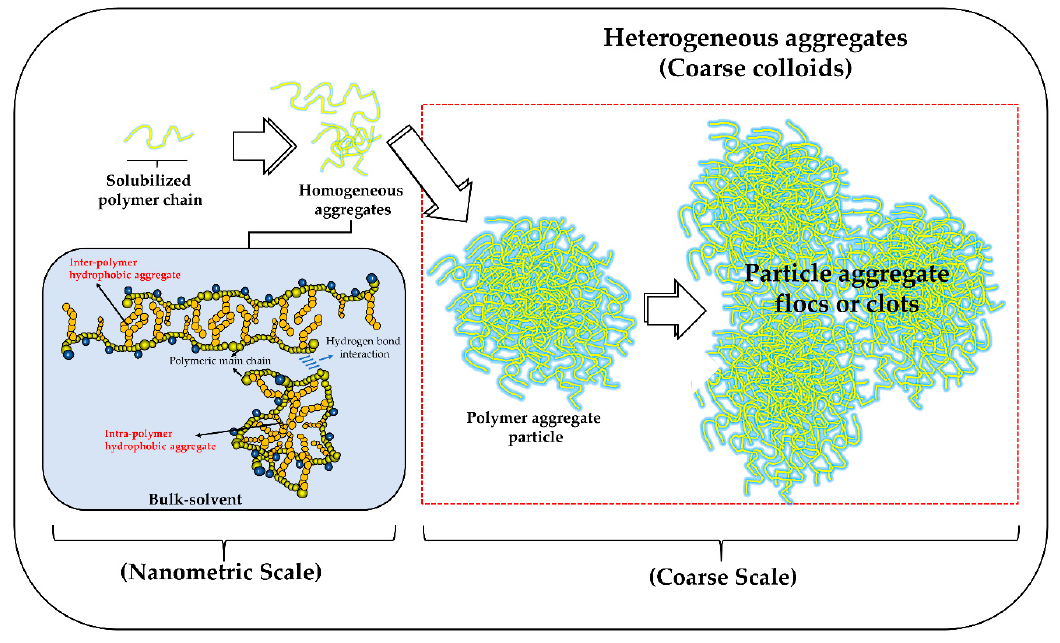
Figure 5. Scheme of formation of inter-polymeric aggregates at different size scales.